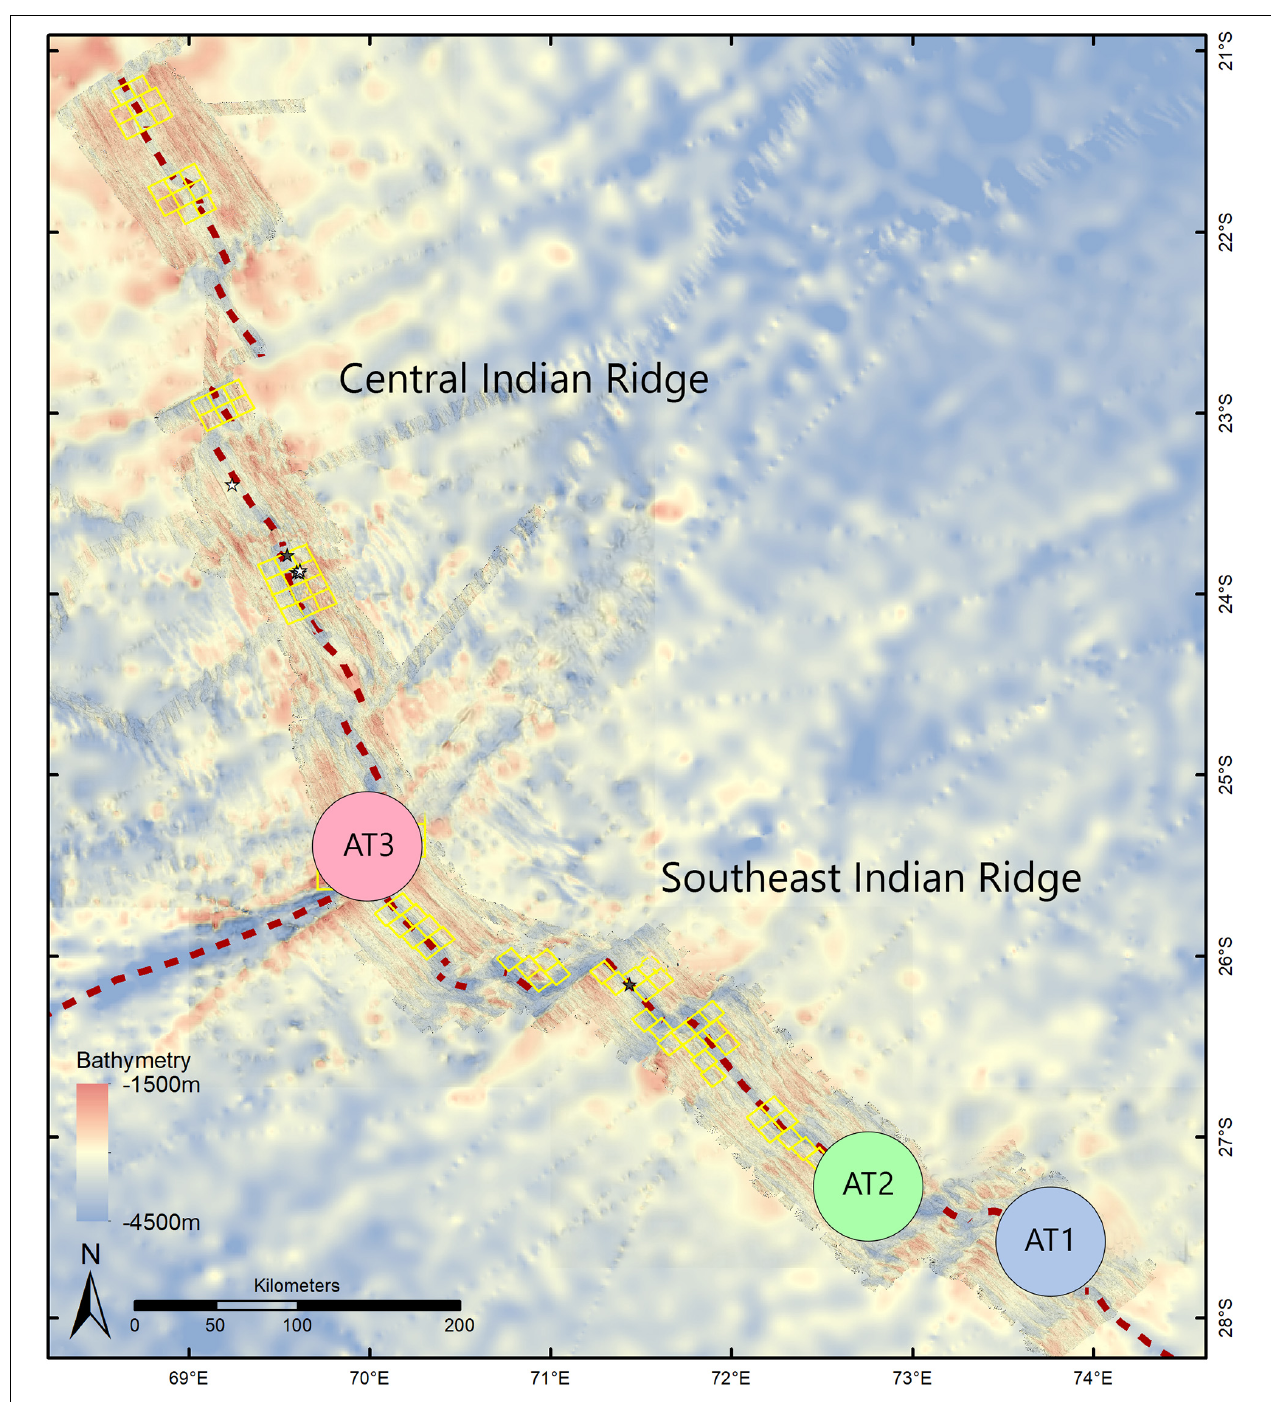
FIGURE 1 | Vent fields sampled on the Southeast Indian Ridge and Central Indian Ridge in the Indian Ocean: AT1 (inactive), AT2 (active), and AT3 (active).